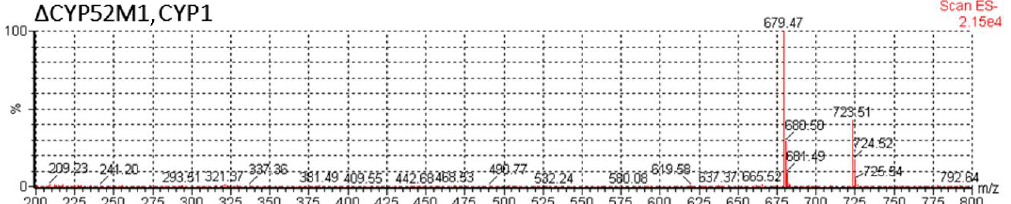
Figure 1. Mass spectrum scan at 24.5 min shows a signal of 16 carbons, zero double bonds (C16:0) di-acetylated acidic sophorolipids (679 m / z ).